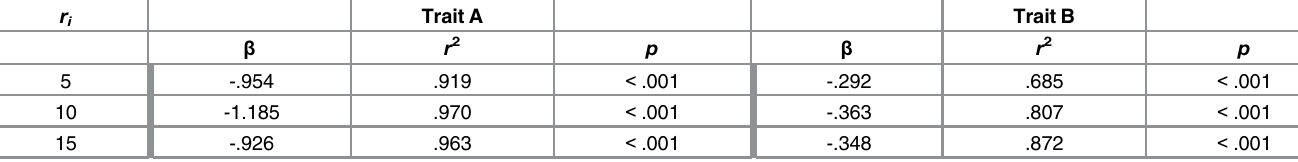
n = 90 runs in each regression.